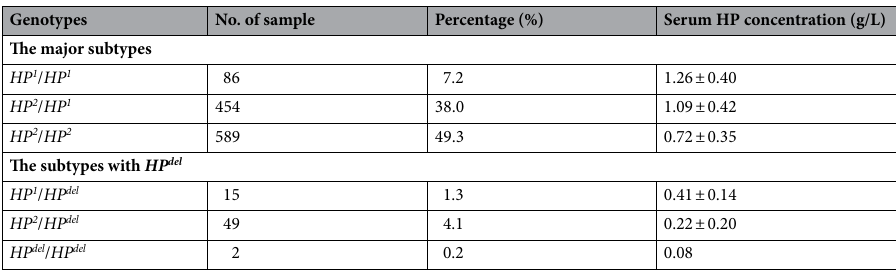
Table 1. The relationship between HP subtype and serum concentration. p values were calculated for the three major subtypes ( HP 1 / HP 1 , HP 2 / HP 1 , HP 2 / HP 2 ) and the subtypes with HP del ( HP 1 / HP del , HP 2 / HP del ), respectively. The HP del / HP del subtype was not included in the analysis because of the small sample size.